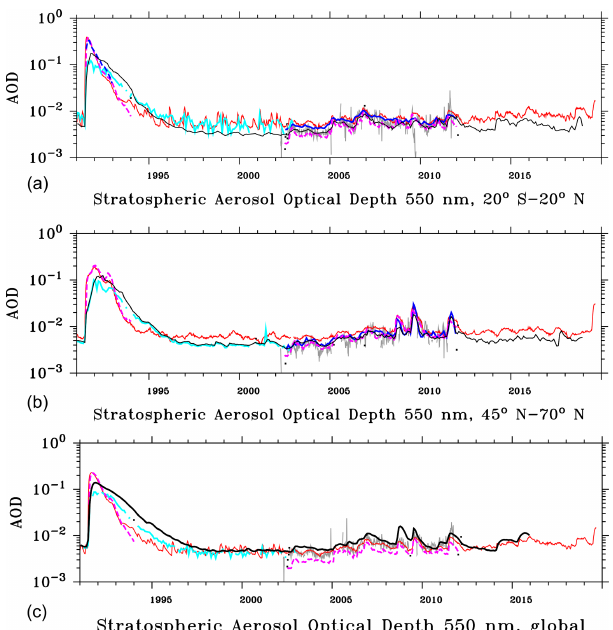
Figure 9. Stratospheric AOD at 550nm wavelength: tropical re- gions 20 ◦ S–20 ◦ N above 16km are shown in panel (a) , the North- ern Hemisphere 45–70 ◦ N above about 13km in panel (b) and global means in panel (c) . Satellite observations from SAGE II (Thomason et al., 2008) are indicated by the light blue line, GOMOS (Bingen et al., 2017) by the grey line and values derived from SAGE + CALIPSO (a) (Santer et al., 2014) and SAGE + OSIRIS (b) (Glantz et al., 2014) by the blue line. The red line shows the EMAC model simulations using the three- dimensional SO 2 injections of Table 2 compared to the simulations of Brühl et al. (2015) (pink dashed line) and the global stratospheric AOD from Schmidt et al. (2018) (black line in panel c ). The black line in panels (a) and (b) represents GloSSAC, derived from extinc- tion at 525nm. For the Pinatubo period the dashed blue line shows the AVHRR observations by Long and Stowe (1994) at 630nm (a) . EMAC and GOMOS as 5d averages, other data monthly.